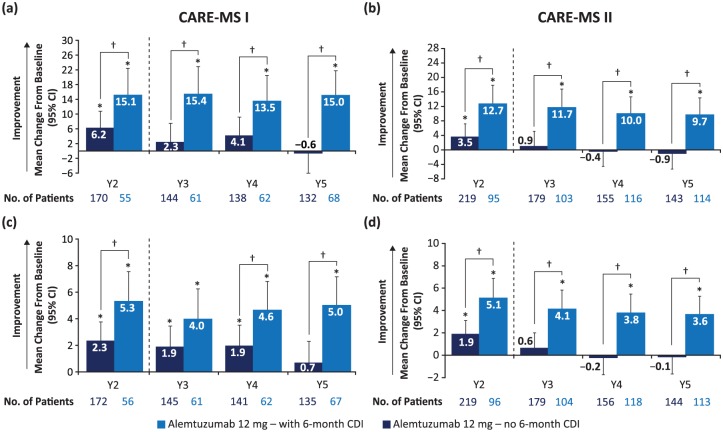
Change from baseline in FAMS score (a, b) and SF-36 PCS (c,d) score in CARE-MS I and II patients with and without 6-month CDI.39,45*Significant change from baseline, p < 0.05; †Significant difference between groups, p < 0.05.CARE-MS, Comparison of Alemtuzumab and Rebif® Efficacy in Multiple Sclerosis; CDI, confirmed disability improvement; FAMS, Functional Assessment of Multiple Sclerosis; PCS, Physical Component Summary; SF-36, 36-Item Short-Form Survey; Y, year.